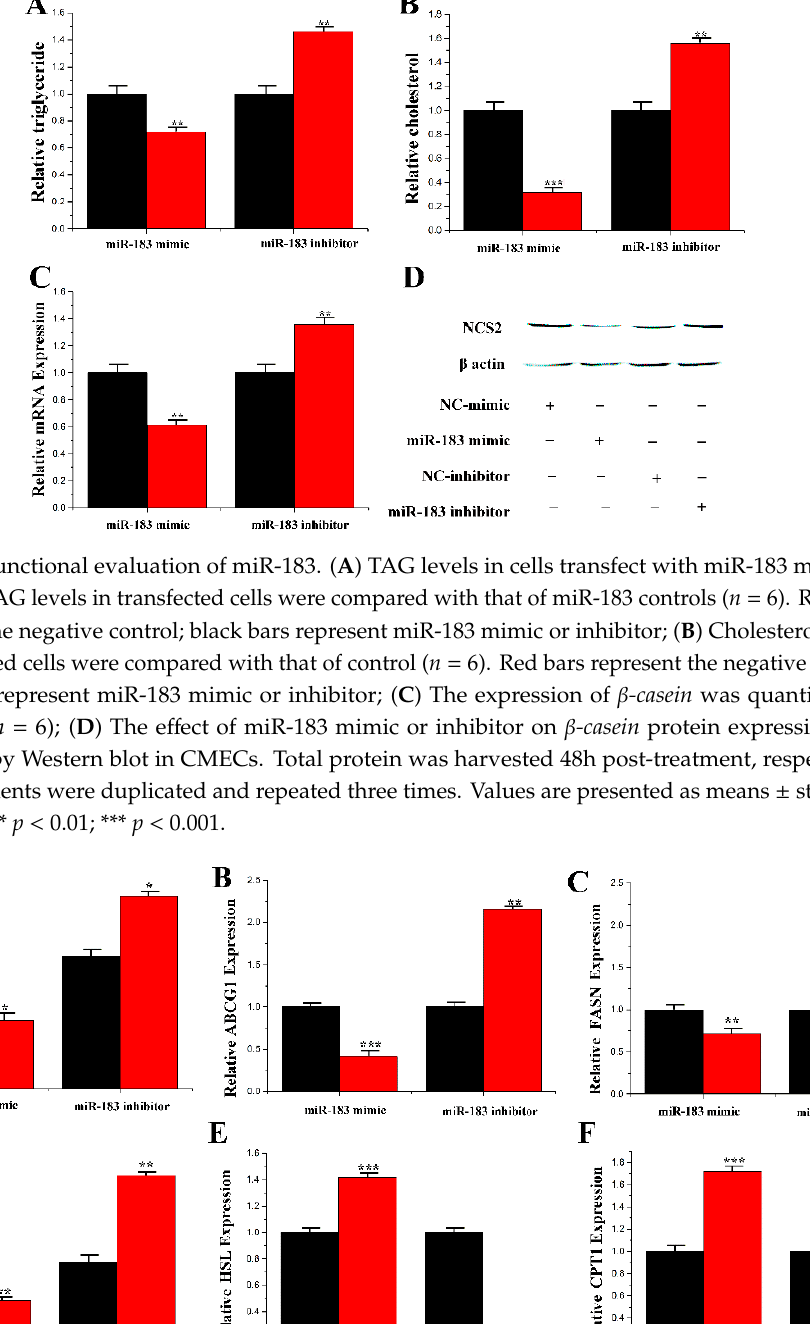
Figure 8. Expression of fatty acid metabolism-related genes. ( A ) The mRNA expression of SCD ; ( B ) The mRNA expression of ABCG1 ; ( C ) The mRNA expression of FASN ; ( D ) The mRNA expression of ABCA1 ; ( E ) The mRNA expression of HSL ; ( F ) The mRNA expression of CPT1 . The mRNA expression of SCD , ABCG1 , FASN , ABCA1 , HSL and CPT1 were quantified by RT-qPCR ( n = 6). Red bars represent the miR-183 mimic; black bars represent the miR-183 inhibitor; All experiments were duplicated and repeated three times. Values are presented as means ± standard deviation, * p < 0.05; ** p < 0.01; *** p <